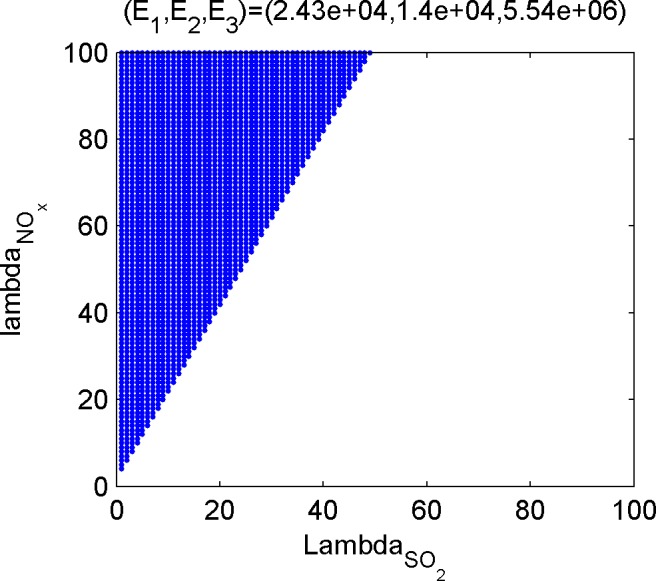
The dominant set relevant for (E1,E2,E3) = (2.43e+04,1.4e+04,5.54e+06).